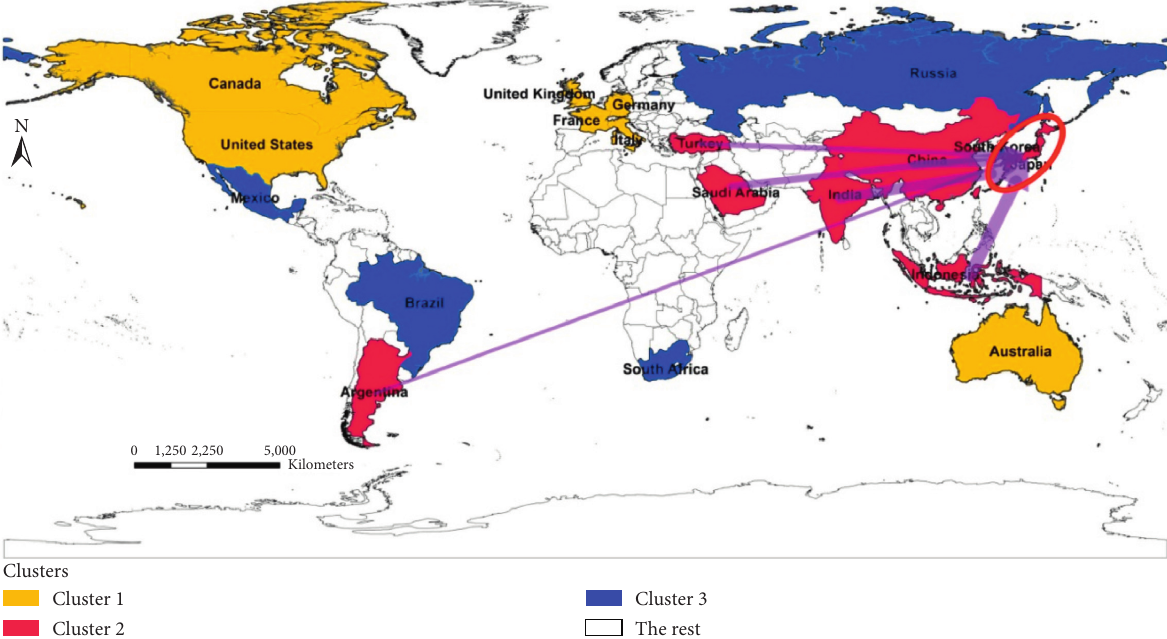
Figure 9: The volatility spillovers from SSE Composite (China), MERVAL (Argentina), BSE Sensex (India), Jakarta Composite (Indonesia), TASI (Saudi Arabia), and ISE 100 (Turkey) to Nikkei 225